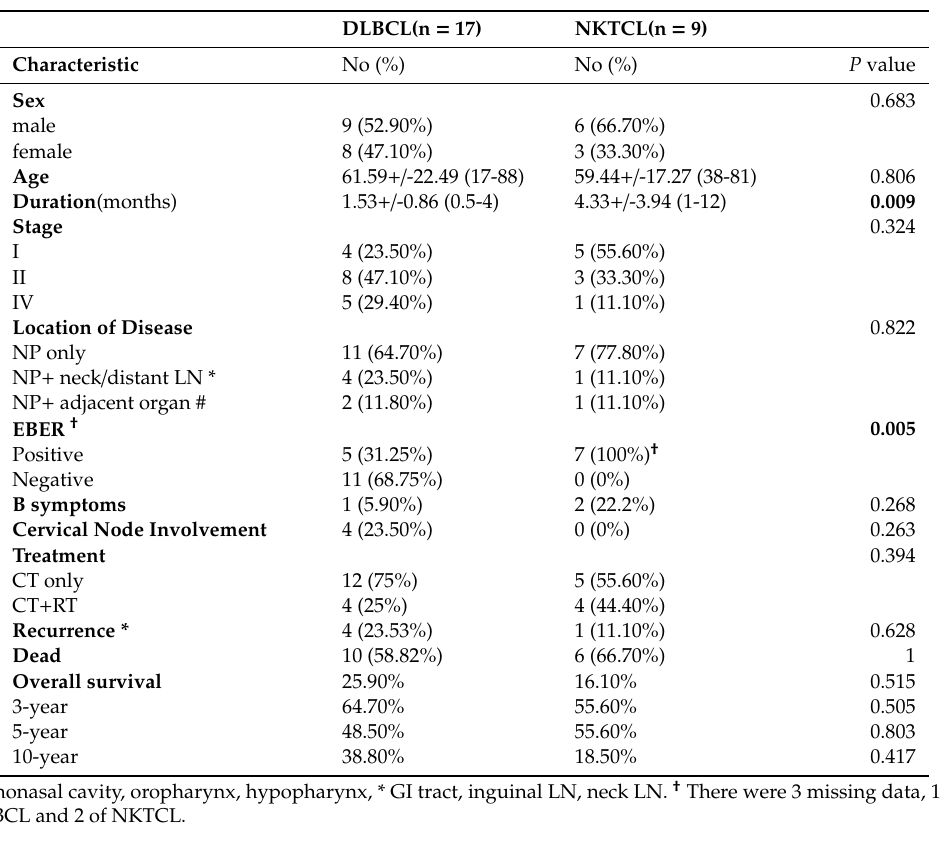
Table 2. Demographic and histopathological characteristics of NP-DLBCL and NP-NKTCL patients.